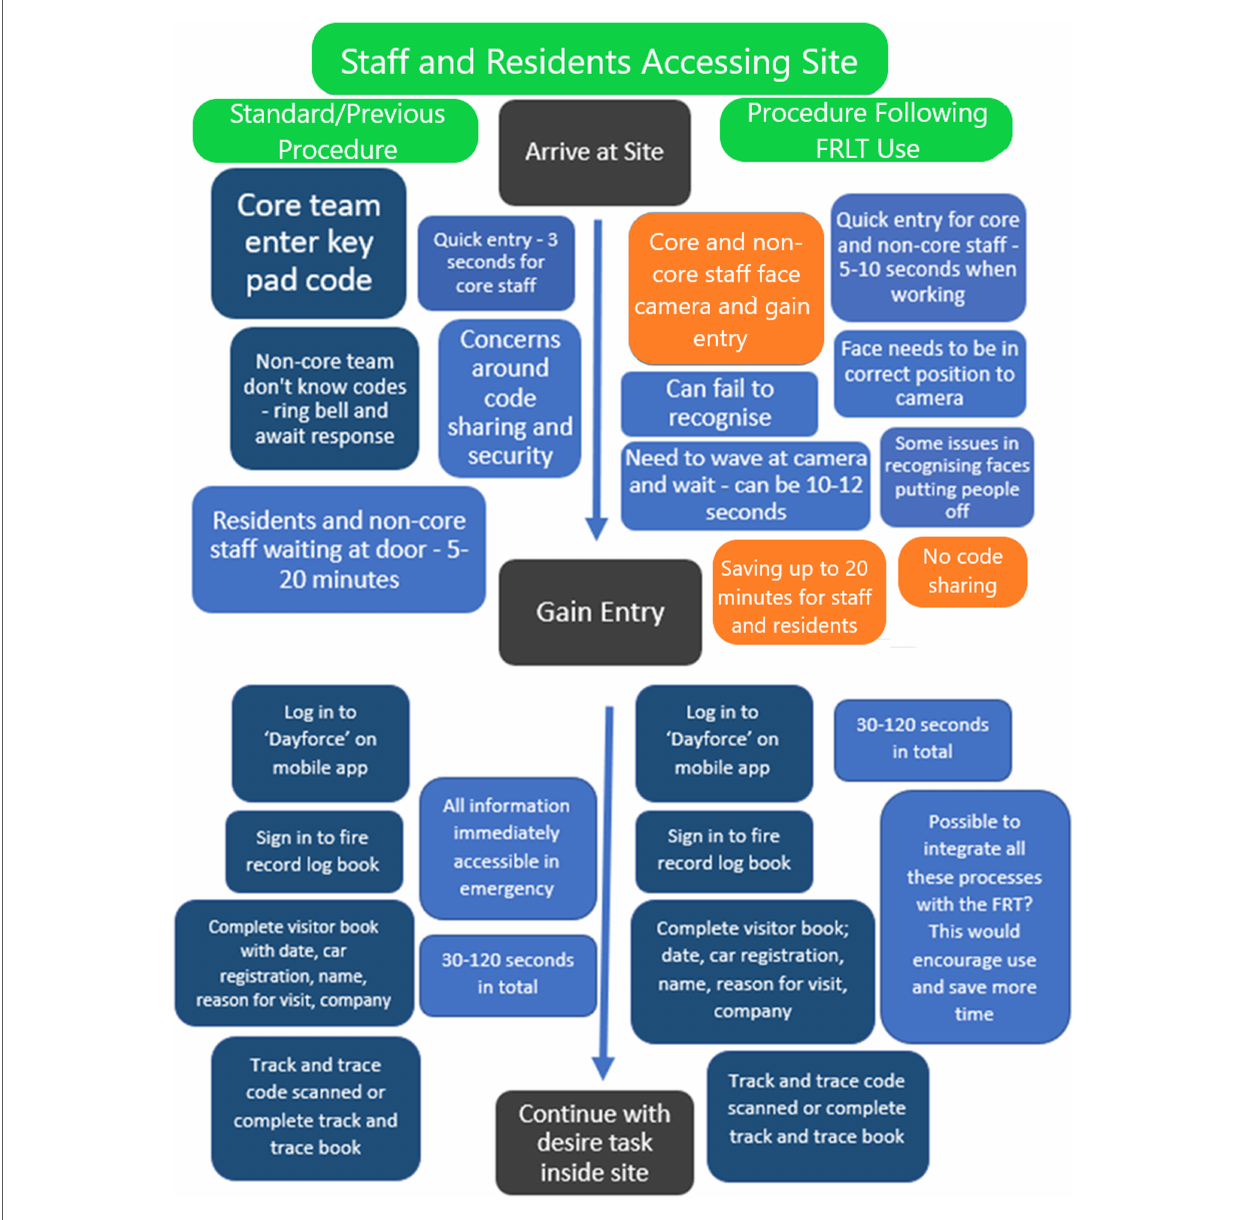
FIGURE 3 Process map for accessing residential care sites before FRLT implementation (previous procedure – left of the fi gure) and following FRLT implementation (right of the fi gure) for staff and site